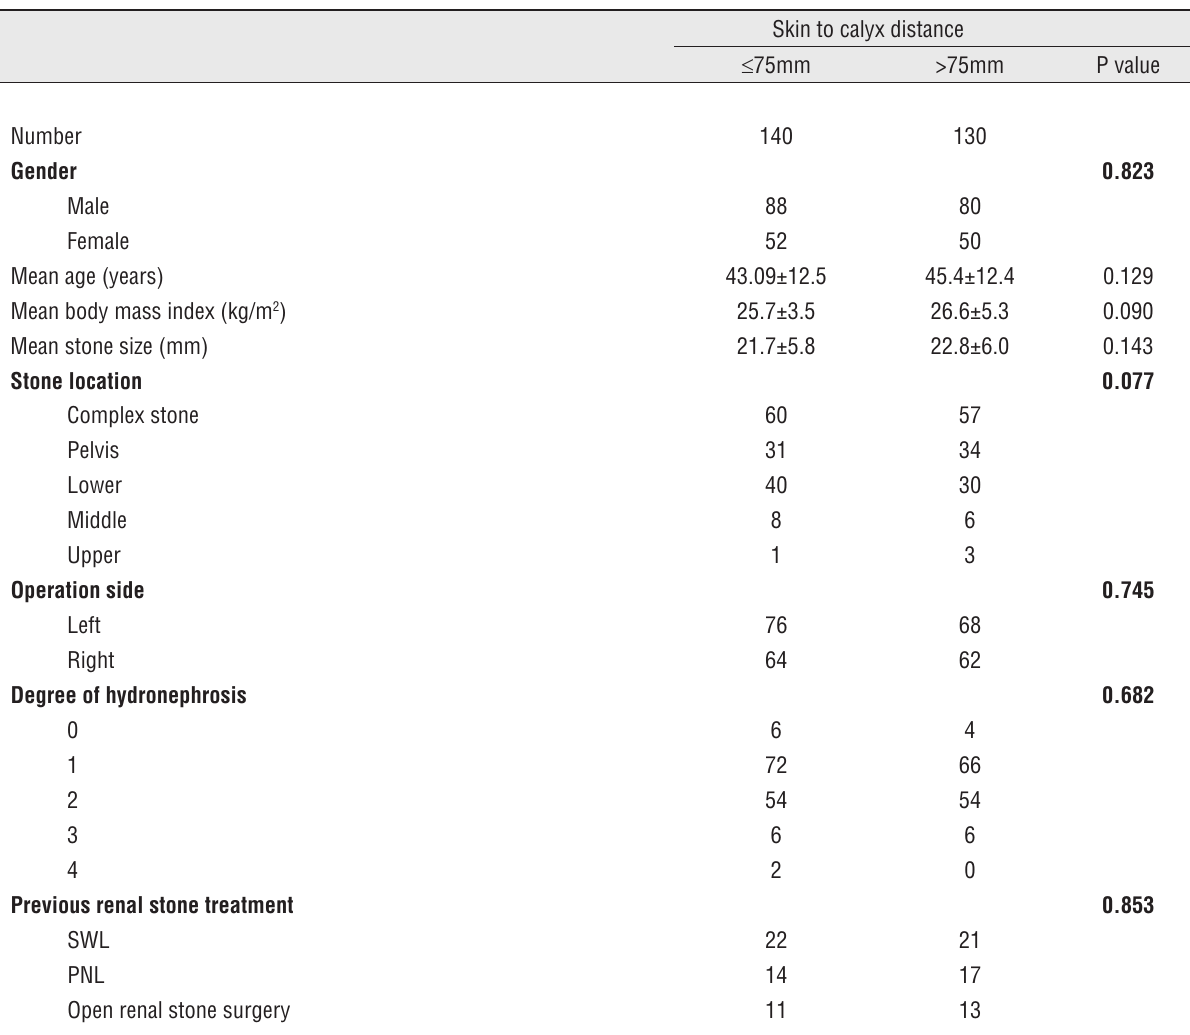
Table 1 - comparison of preoperative